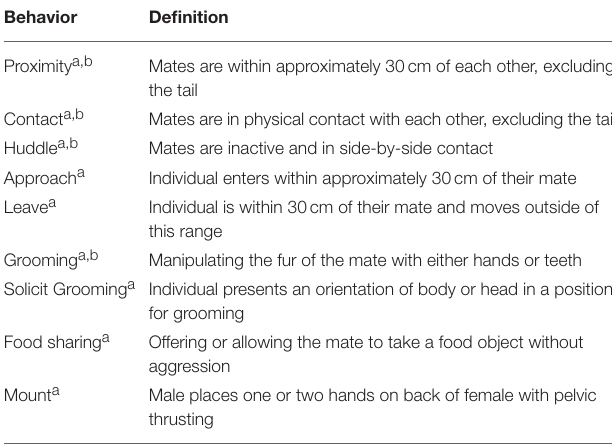
TABLE 1 | Ethogram of marmoset ( Callithrix jacchus ) behavior recorded during reunion